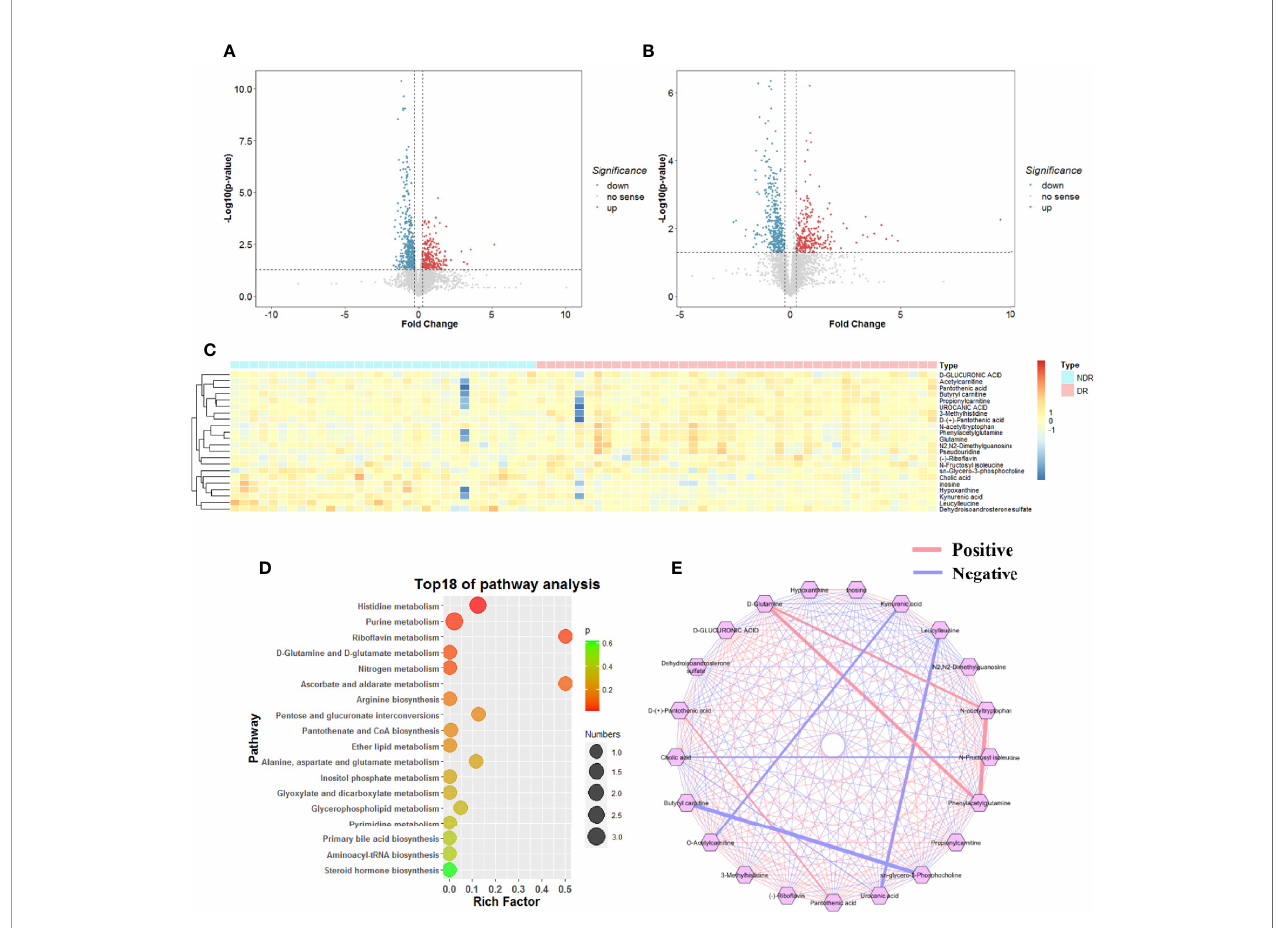
FIGURE 3 | Representative Volcano plot (fold change >1.2 and p-value < 0.05) in ESI (+) mode (A) and ESI (+) mode (B) metabolomics data. (C) Representative heatmap of signi fi cant different metabolites (fold change >1.2, VIP>1 and p-value < 0.05). (D) Correlation-based metabolic network analysis. (E) Metabolic pathway